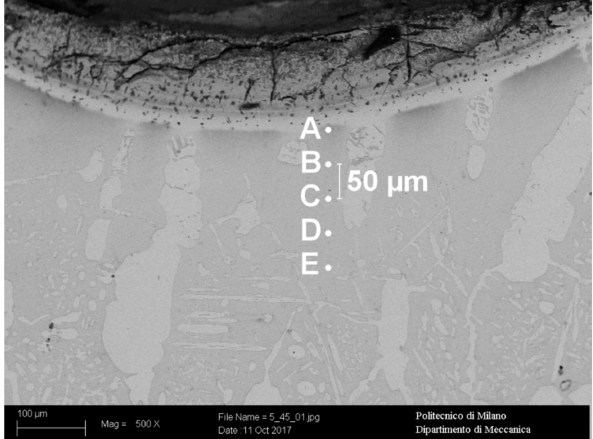
Figure 10. Scanning electron microscope secondary electron detector (SEM/SE) image of the surficial